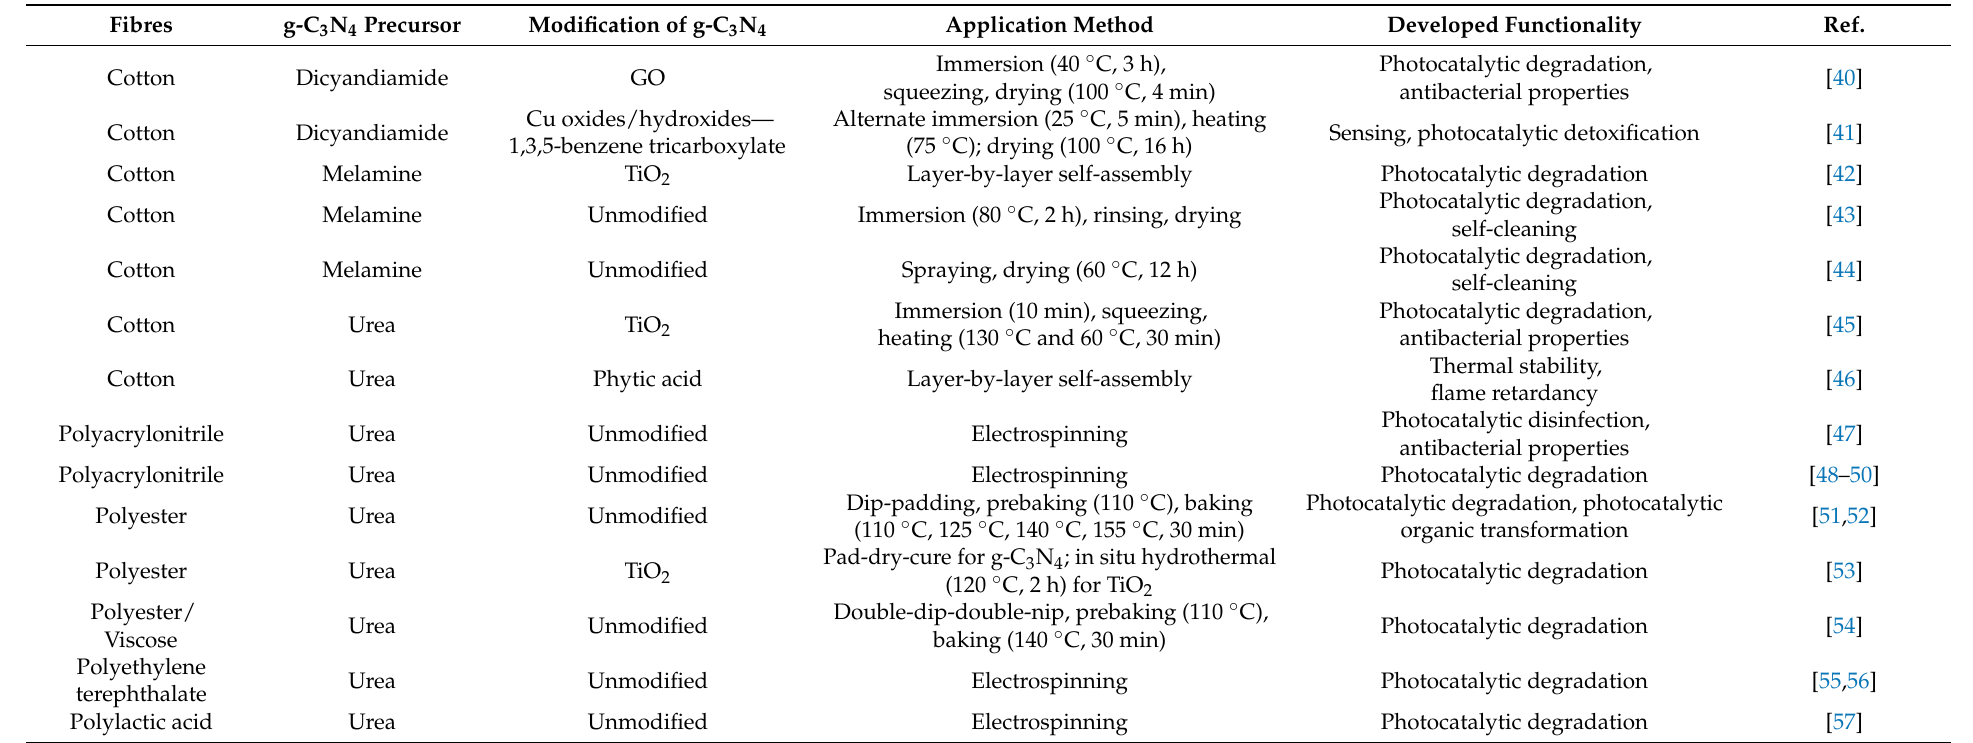
Table 1. Textile fibres, g-C 3 N 4 source, and its modifications, application methods, and developed